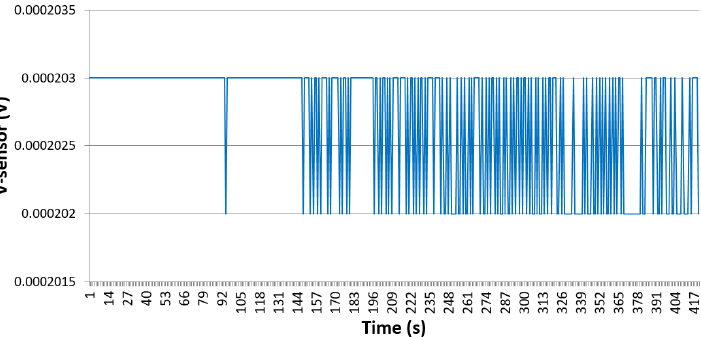
Figure 18. V out vs. time at a constant applied heat surrounding the sensing element. V out as a function of the applied heat around the sensing element is presented in Figure 19. An increment of 50 µ W. at a heating element located in the sensor’s surrounding corresponds to an increment of 1 µ V. at the bridge output voltage. This increment is illustrated in the reading zoom-in presented in Figure